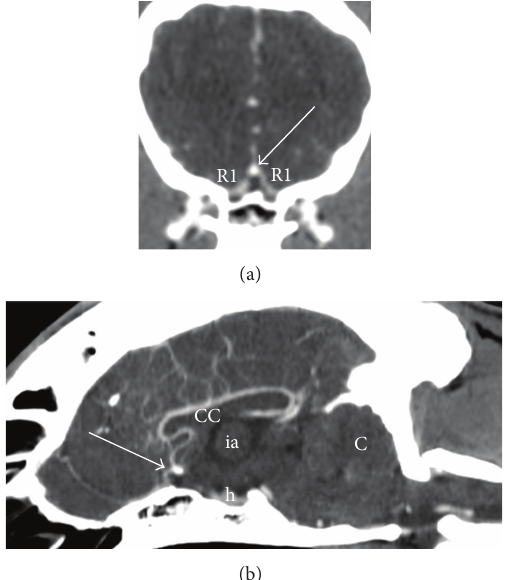
Figure 1: Multiplanar reformatted images (MPRs) of the neuro- cranium. (a) Transverse (slight oblique) view showing the small aneurysm (arrow) at the joining point of the two R1 segments of the left and right rostral cerebral arteries. (b) Mid-sagittal view of the same dog. The arrow indicates the aneurysm. CC: corpus callosum; ia: interthalamic adhesion; C: cerebellum; h: hypophysis.